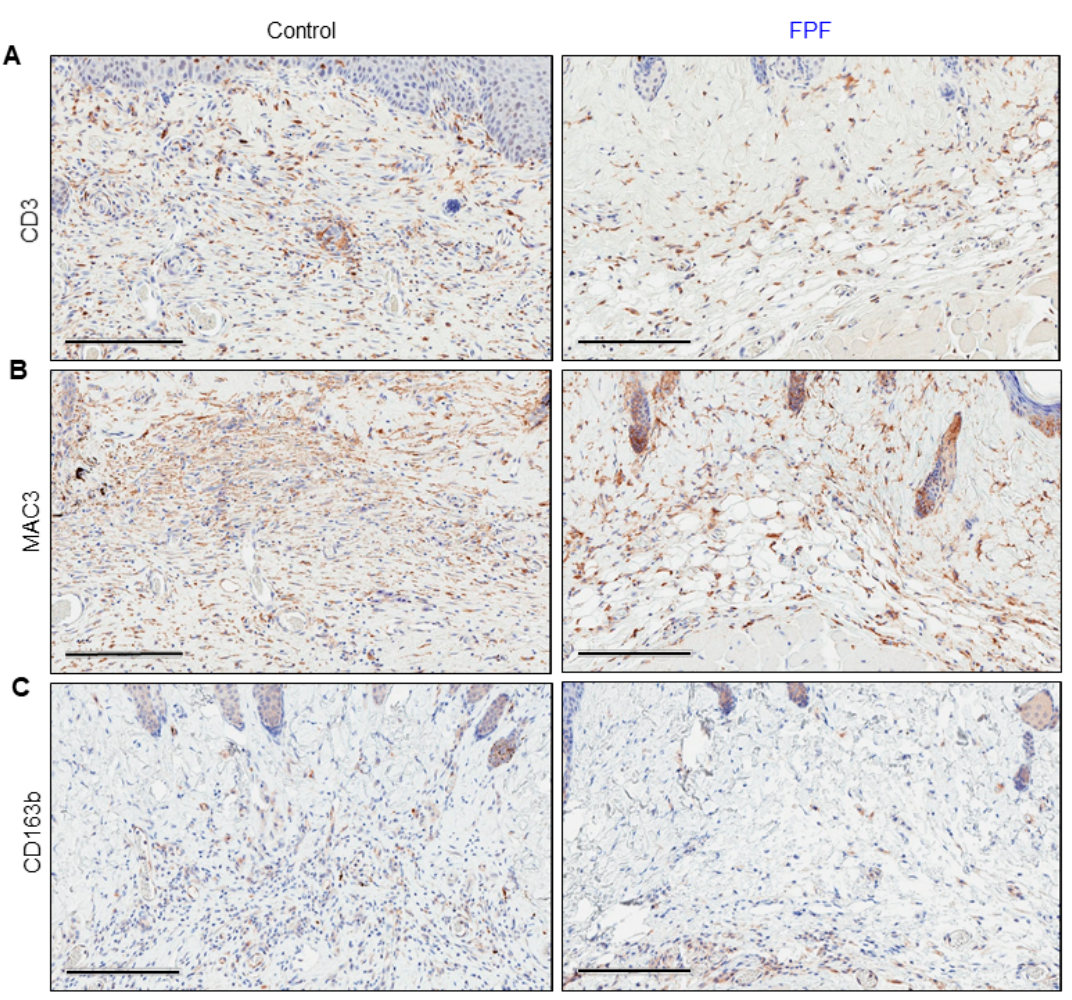
Figure 5. Anti-inflammatory effect of FPF on bleomycin-treated skin. Immunohistochemical analysis of bleomycin-treated control ( left panel ) and FPF-treated ( right panel ) tissue samples were collected at Day 21 and stained with antibodies to CD3 to detect T-cells ( A ), MAC3 to detect macrophages ( B ), and CD163b to detect M2-polarized ( C ). Amelioration of dermal tissue inflammation in FPF-treated mice compared to control mice was observed, as indicated by the lower number of CD3-positive, MAC3-positive, and CD163b-positive cells. Representative images of five animals per group are shown. Scale bars = 200 µm.